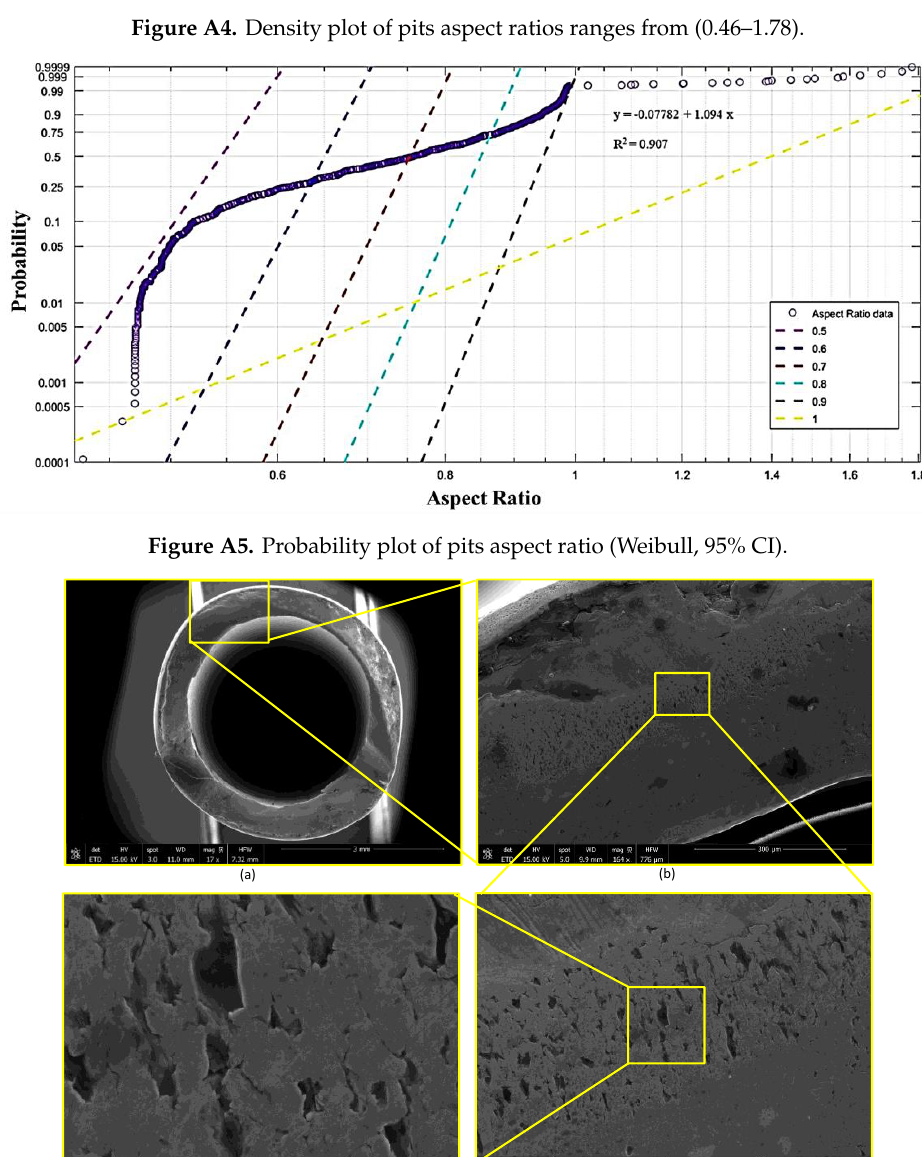
Figure A7. ( a ) Montage of SEM images showing fracture surface of the cortical screw (CS1), ( b – d ) striations, river lines perpendicular to striations. River lines point towards the initiation point (river lines run bottom left to top right).